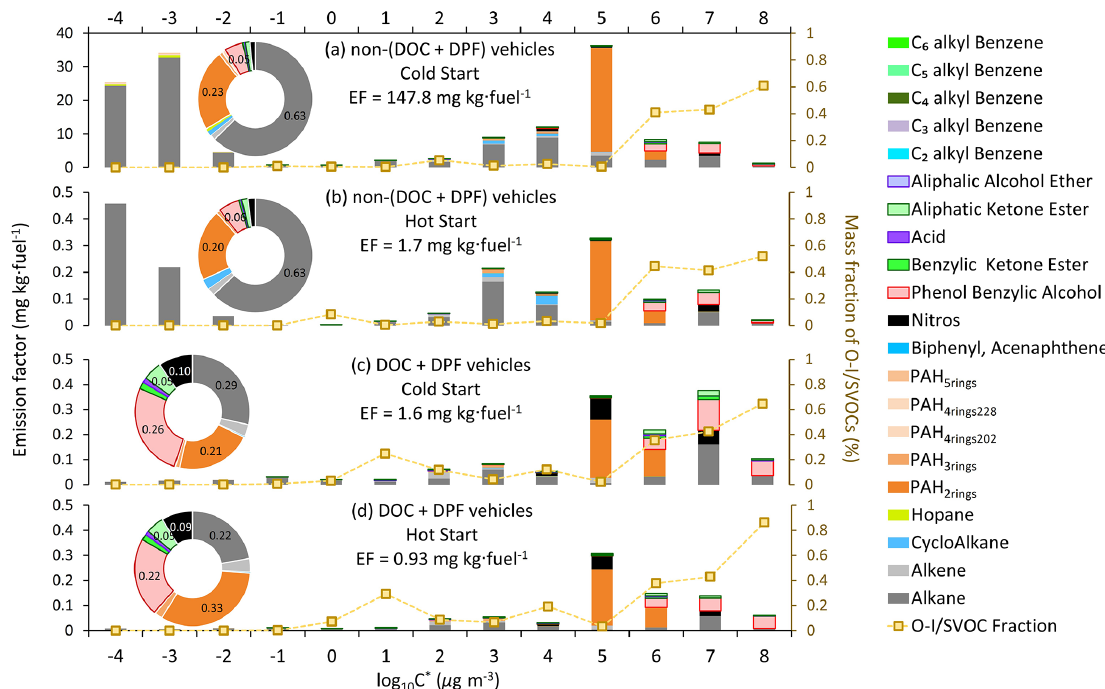
Figure 2. EFs of particulate I/SVOCs under the cold-start and hot-start driving conditions. Different colored bars represent different com- pound categories. The mass fraction of the O-I/SVOCs, indicated by the scattered squares, is scaled by the right axis. The inset pie charts are the mass fractions of different compound categories, and the numbers show the mass contributions of the top few